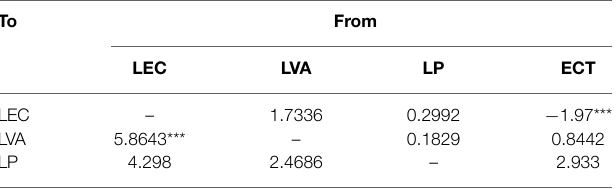
TABLE 5 | Results of VECM granger causality test .